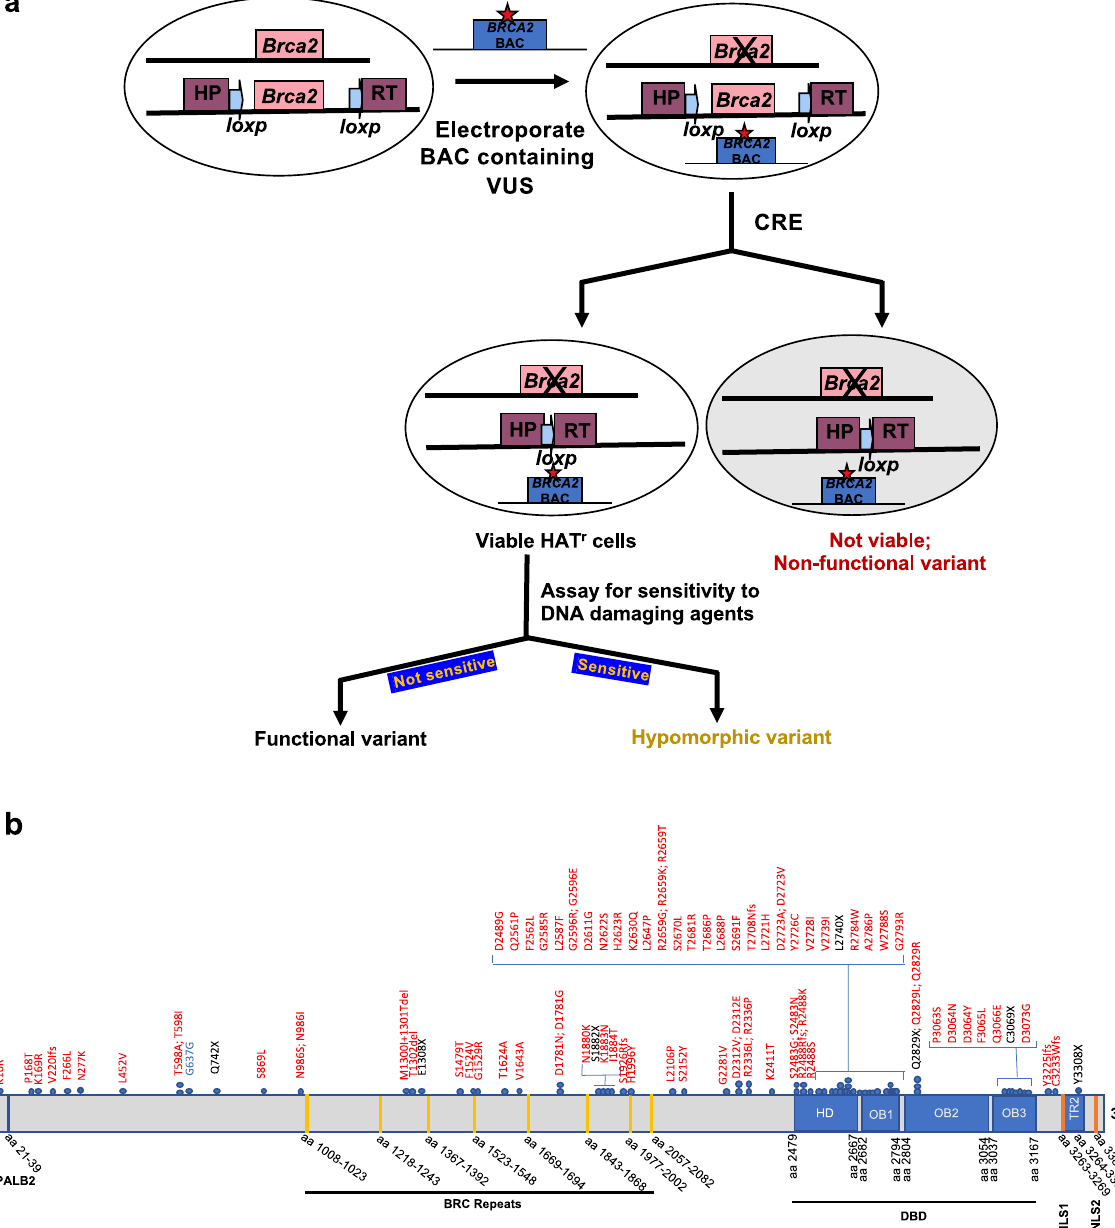
Fig. 1 Mouse ES cell-based functional assay for BRCA2 variants. a Schematic representation of the functional assay. BAC DNA encoding human BRCA2 gene with any variant was introduced into PL2F7 mES cells containing a conditional allele and a knockout allele of Brca2 . Conditional allele was further deleted by CRE and the recombinants were selected on HAT containing media. Depending on the impact of BRCA2 variants, HAT r cells may or may not be viable. Viable HAT r cells were further tested for sensitivity to different DNA damaging agents to distinguish between variants that have no impact on function and those that have some loss of function (hypomorphic). Star in the BAC construct represents variant. Two halves of HPRT mini gene are marked in solid boxes as HP and RT. Solid arrows denote loxP sites. b Schematic diagram of BRCA2 protein with different domains and position of variants selected. Different domains are marked as colored boxes and the amino acids (aa) for the respective domains are noted below. HD helical domain, DBD DNA-binding domain, OB oligonucleotide binding fold, TR2 C-terminal RAD51-binding site, NLS nuclear localization signal 15,43,44 . Variants selected for analysis are denoted as colored solid circles on top. Missense, silent or synonymous and nonsense variants are marked in red, blue, and black colors,